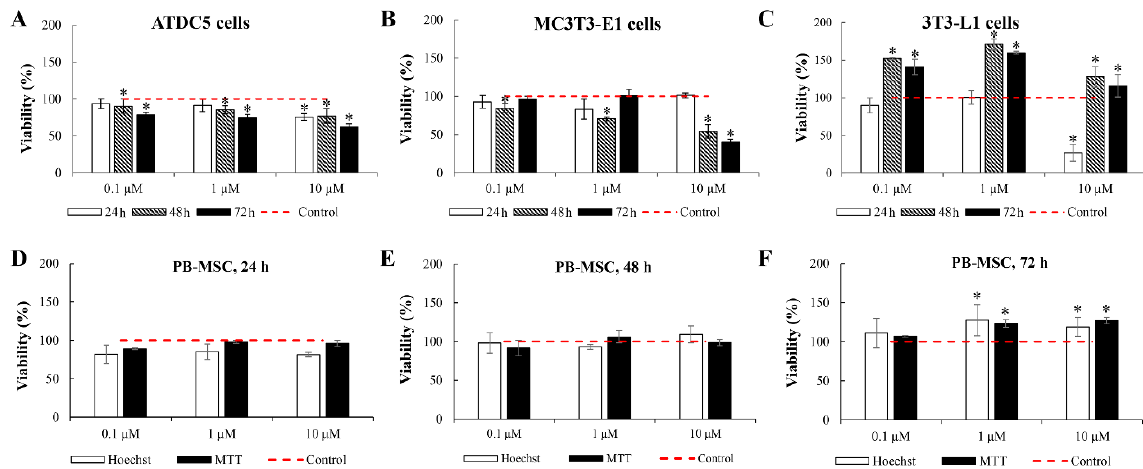
Figure 1. Acellular porcine hemoglobin (PHb) modulates proliferation of mesenchymal cells. Viability of ATDC5, MC3T3-E1, and 3T3-L1 cells ( A – C ) and PB-MSCs ( D – F ) cultured for 24, 48, and 72 in growth medium (GM) supplemented with PHb. ( A – C ) The cell viability assessed by MTT assay. ( D – F ) The cell viability assessed by MTT assay and Hoechst labeling. Results are percentages of the corresponding control (viability of control cells cultured in GM only; set at 100%). Mean ± SD of three independent experiments is shown. * p < 0.05, compared to the corresponding control.